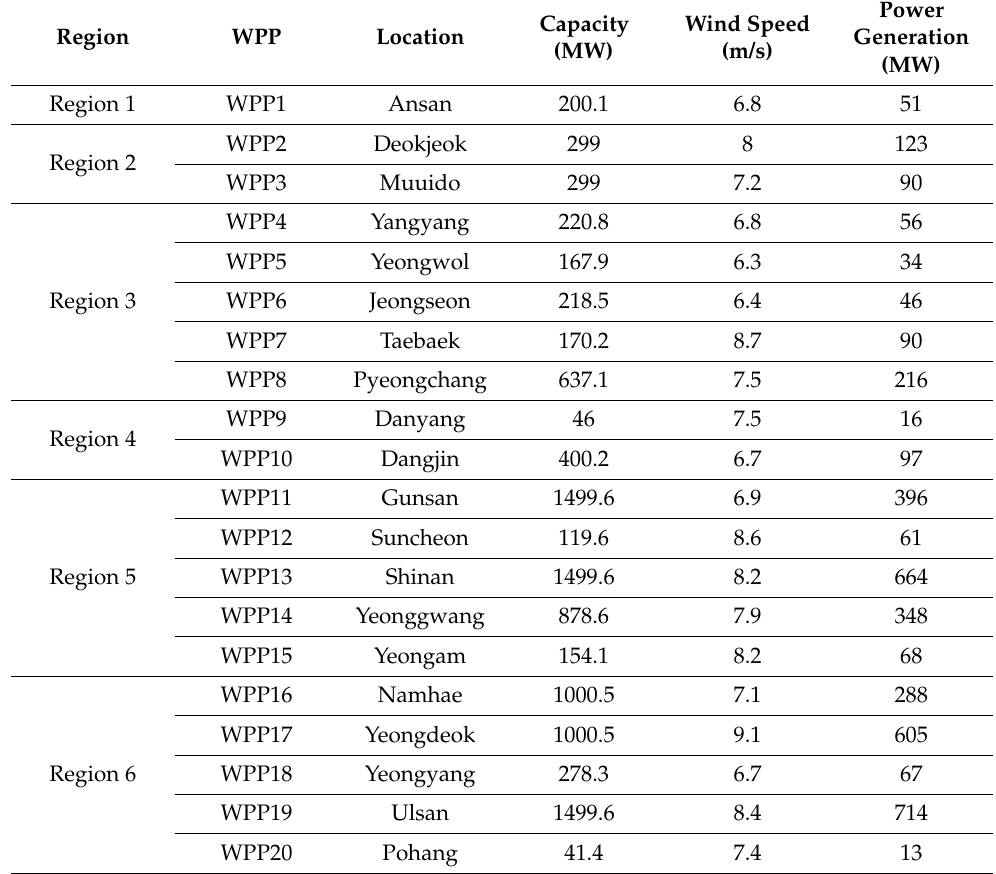
Table 2. WPPs characteristics in Korean electric power